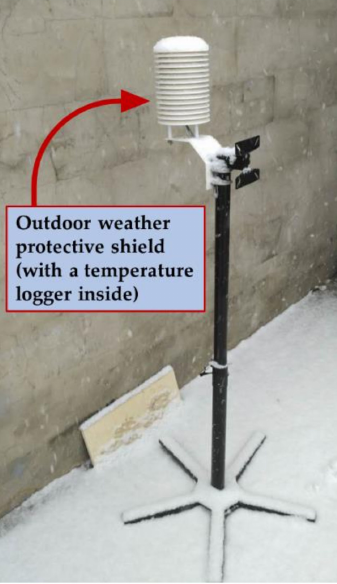
Figure A1. An outdoor air dry-bulb temperature logger with protection installed in household